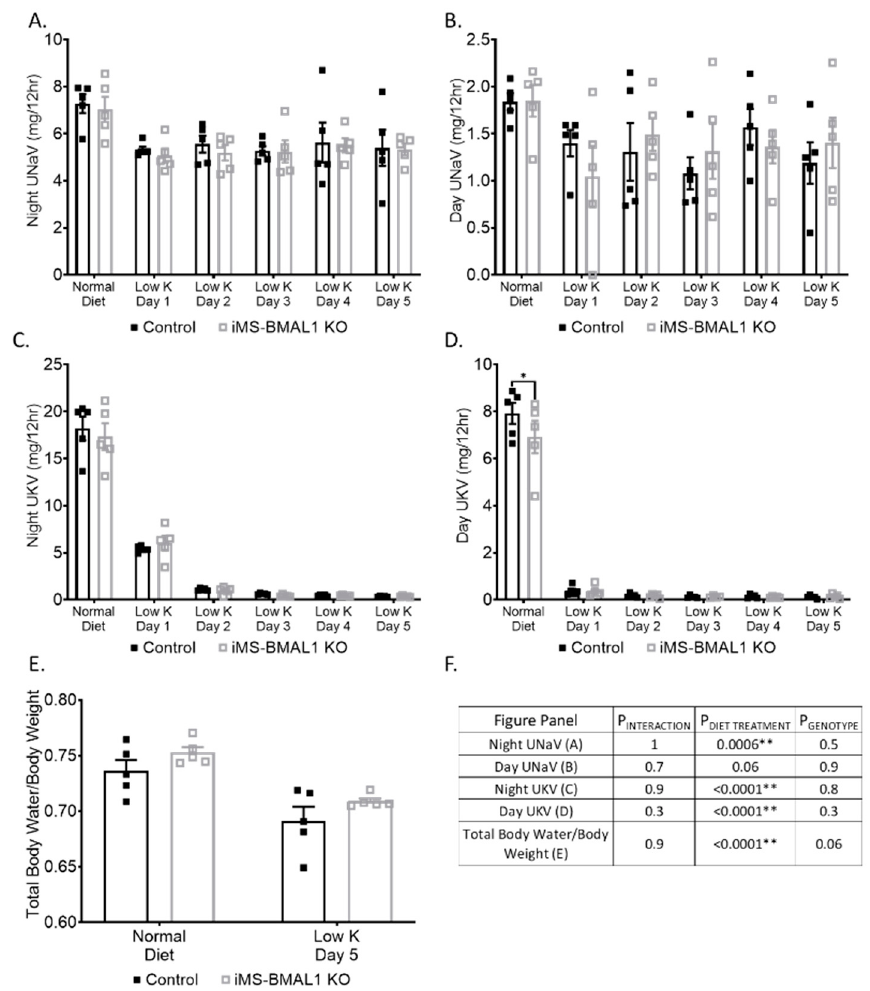
Figure 2. There was no difference in sodium handling between groups following potassium depletion. Sodium excretion during the ( A ) nighttime and ( B ) daytime from male control and iMS-BMAL1 KO mice treated with normal and five days of a potassium-depleted diet. Potassium excretion during the ( C ) nighttime and ( D ) daytime in the same mice. Urine collections were carried out every 12 h. ( E ) Total body water normalized to body weight from mice before and after the five-day treatment with a potassium-depleted diet. ( F ) Statistical analysis for each panel in Figure 2. n = 4–5. Values are mean ± SEM. Two-way ANOVA with was used to compare groups. Sidak’s multiple comparisons test was used to compare between control and KO within treatment groups. * = p < 0.05, ** = p < 0.001; UNaV = urinary sodium excretion; UKV = urinary potassium excretion; Normal = normal diet; Low K = day of potassium-depleted diet treatment.